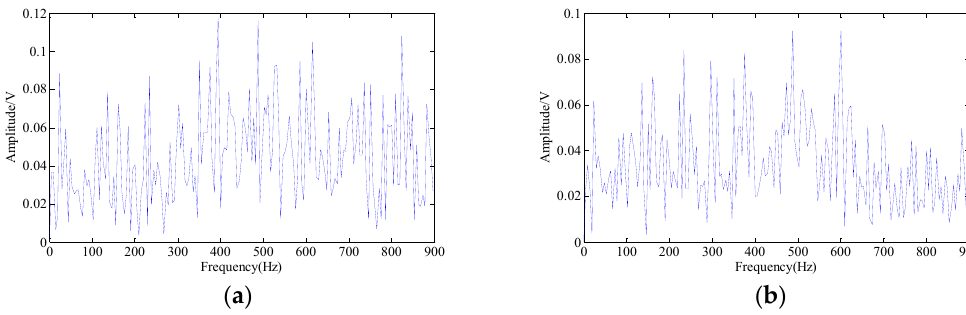
Figure 14. The result provided by empirical mode decomposition and independent component analysis (EMD-ICA): ( a ) recovered No. 1 fault signal; and ( b ) recovered No. 2 fault signal.